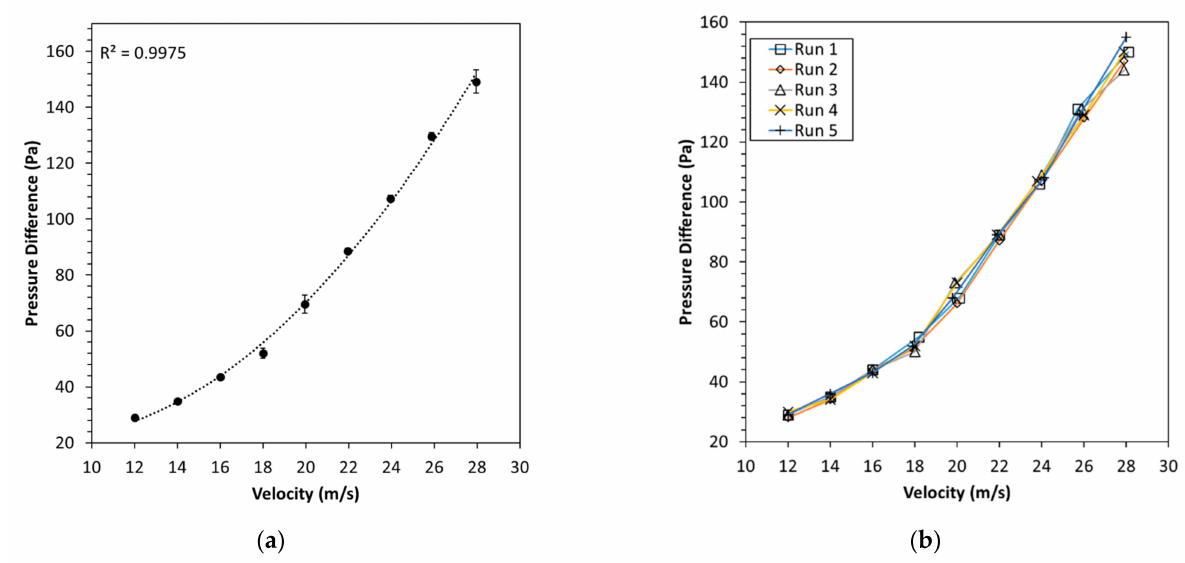
Figure 9. Experimental results for 4 mm dimples engraved on NACA/elliptical profile; ( a ) average of 5 runs; ( b ) 5 individual runs. Figure 10a highlights the average pressure drop for the 6 mm-dimpled fin whereas Figure 10b presents the results for the five individual runs undertaken. The trendline corresponds to a second-order polynomial equation, the coefficient for which is shown in Figure